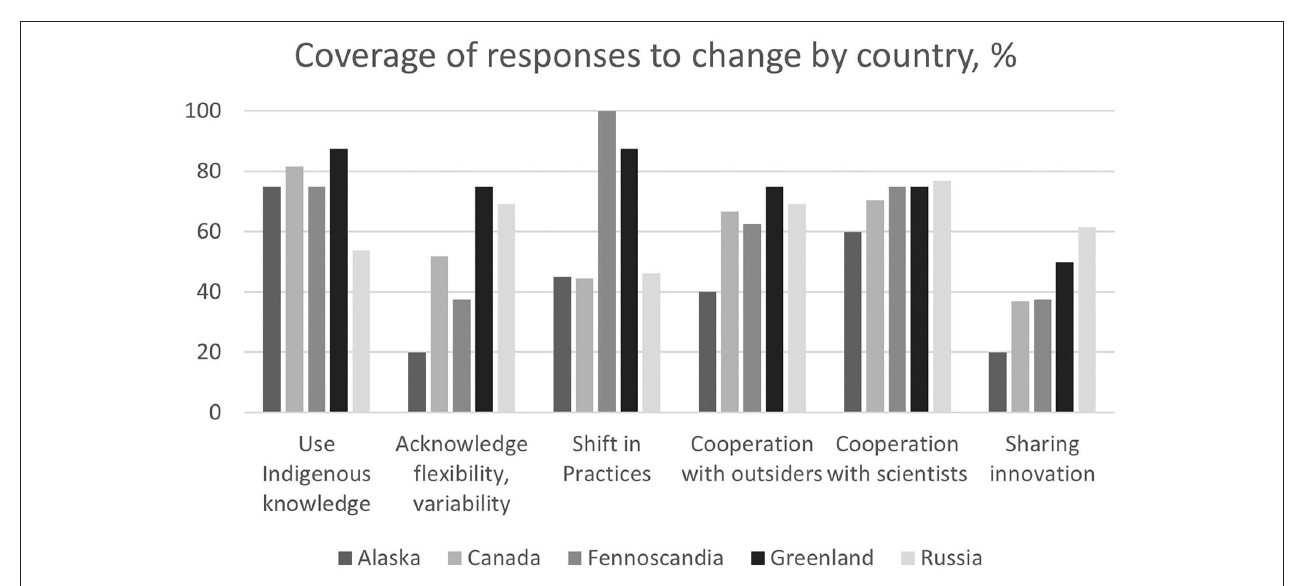
FIGURE 6 | Coverage of responses to change by country, % of total